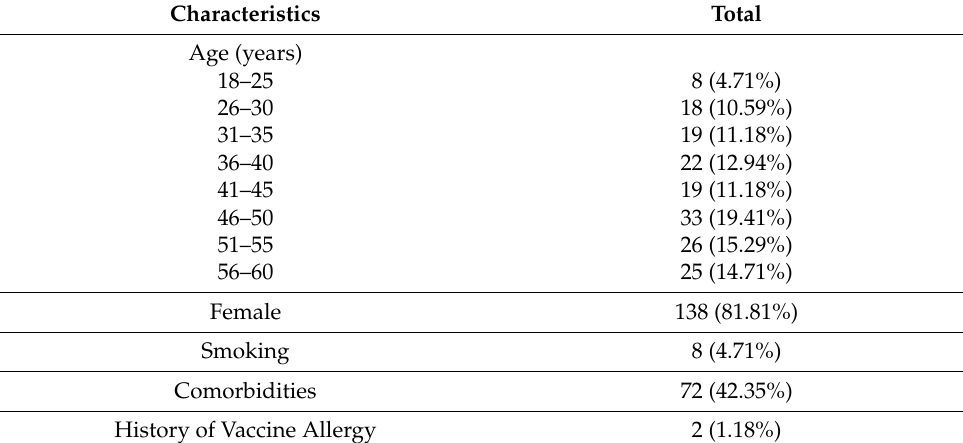
Table 1. Characteristics of Participants ( n = 170).